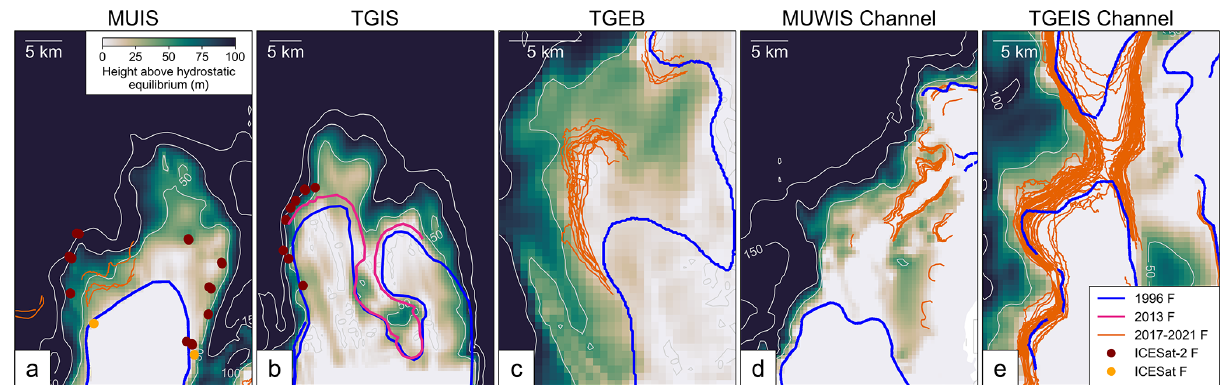
Figure 11. Height above hydrostatic equilibrium in Moscow University Ice Shelf (MUIS) main glacier trunk (a) , Totten Glacier Ice Shelf (TGIS) main glacier trunk (b) , Totten Glacier East Branch (TGEB) (c) , Moscow University Western Ice Shelf (MUWIS) ocean channel (d) , and Totten Glacier Eastern Ice Shelf (TGEIS) ocean channel (e) . The DInSAR GLs between 2017 and 2021 mapped in this study are shown as the orange solid lines. The 1996 and 2013 MEaSUREs GLs are shown as blue and pink solid lines, respectively (Rignot et al., 2011, 2016). The ICESat-2-derived Point F locations and ICESat-derived Point F locations derived in this study are shown as maroon and orange dots,